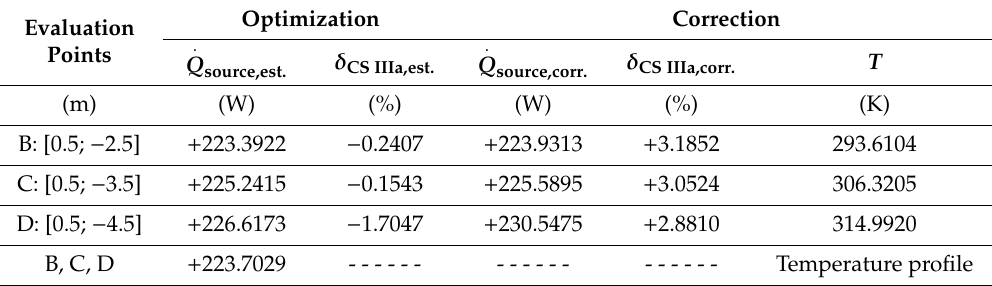
Table 11. Case study IIIa: Estimation of the positive heat source . Q source,corr. to thermodynamic temperatures T B , T C , and T D for evaluation points B, C, and D (for points and a thermal profile).